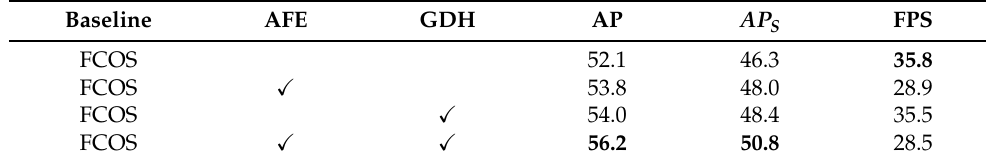
Table 10. Experimental results of the two module on